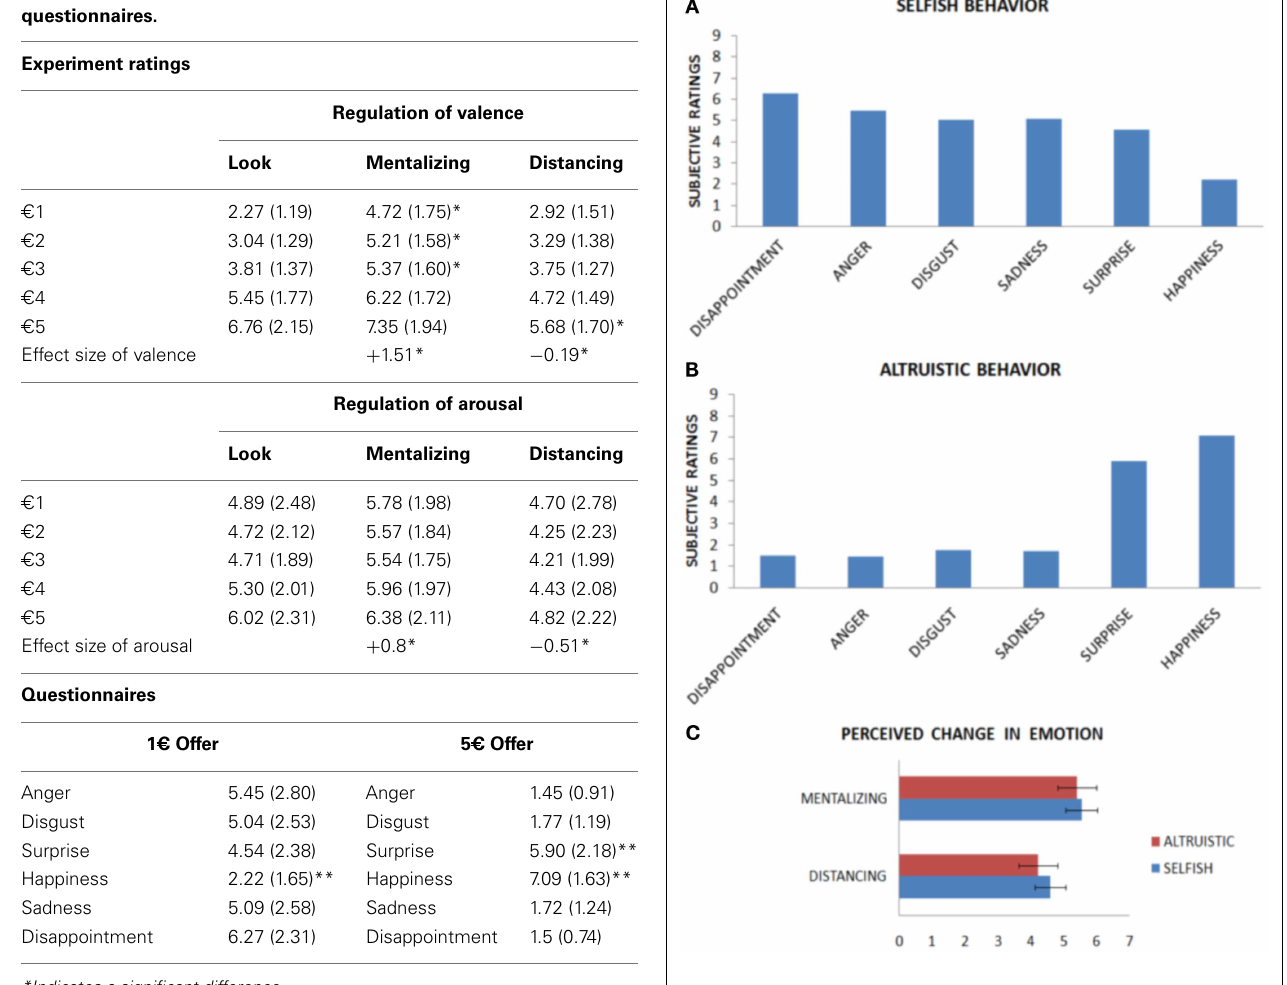
FIGURE 3 | Results from questionnaires after Experiment 1 are presented. Subjective ratings when observing a selfish behavior (A) and an altruistic behavior (B) indicate that emotion regulation involved specific emotions. Moreover, subjects experienced large changes in their emotions when applying the strategies (C) , with mentalizing being superior to